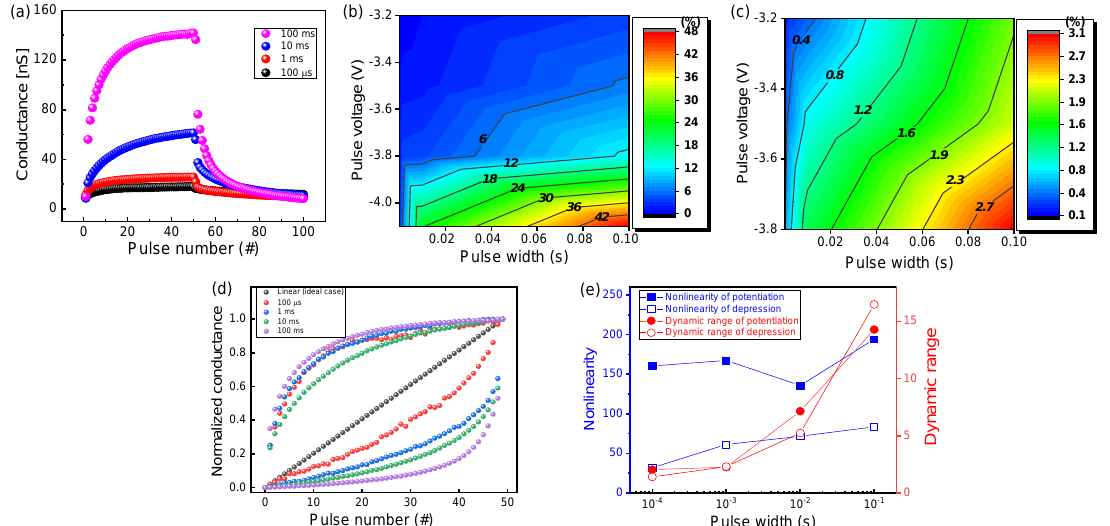
Figure 4. Potentiation and depression characteristics of TiN/Ti/TiO 2 /SiO x /Si device: ( a ) Pulse-width- controlled conductance change; contour maps of ( b ) potentiation and ( c ) depression as a function of pulse voltage and width; ( d ) normalized conductance in different pulse widths; ( e ) nonlinearity and dynamic range as a function of pulse width.